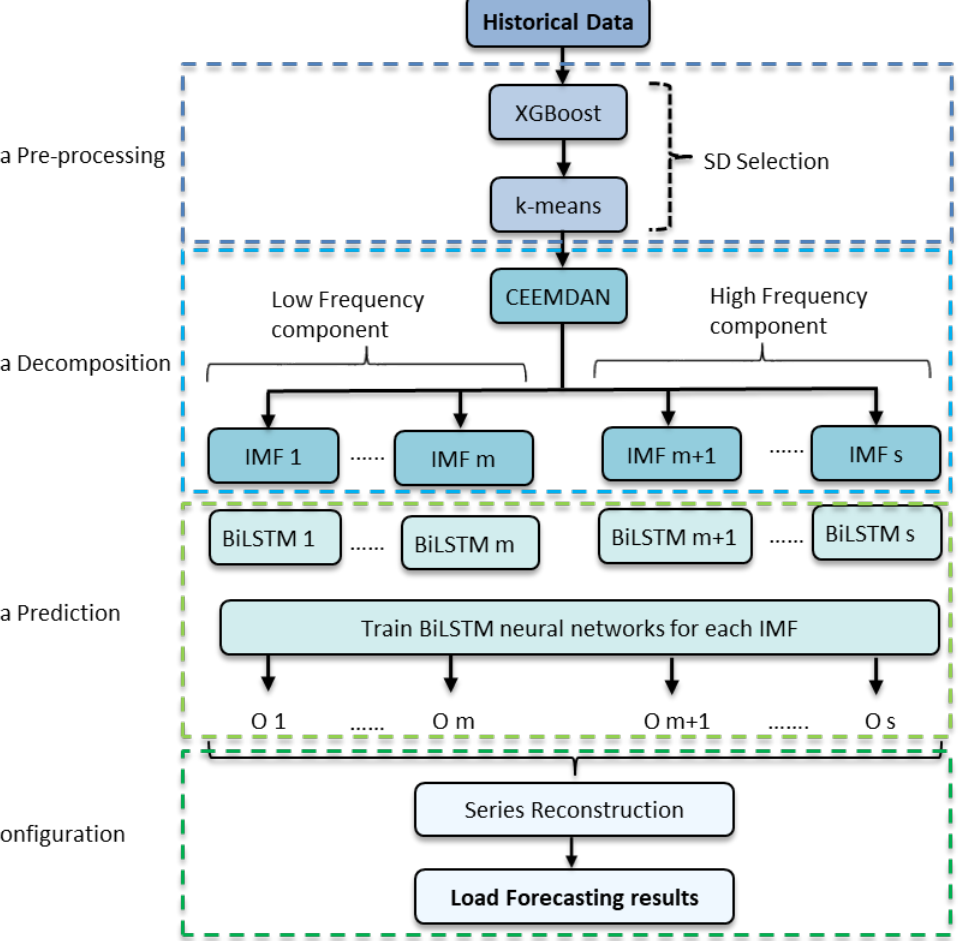
Figure 3. Hybrid forecast model based on SD-CEEMDAN-BiLSTM.